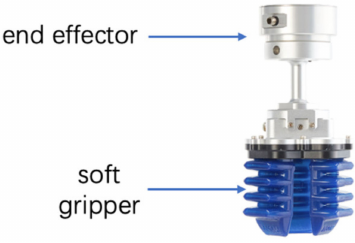
Figure 4. SFG soft gripper [81].